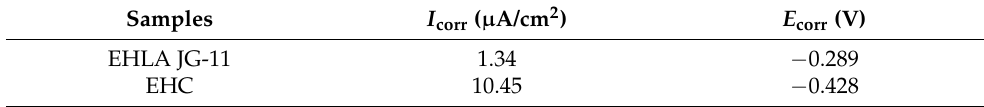
Figure 12. Potentiodynamic polarization curves of the coatings. Table 4. Fitting results of the polarization Table 4. Fi tt ing results of the polarization curves.